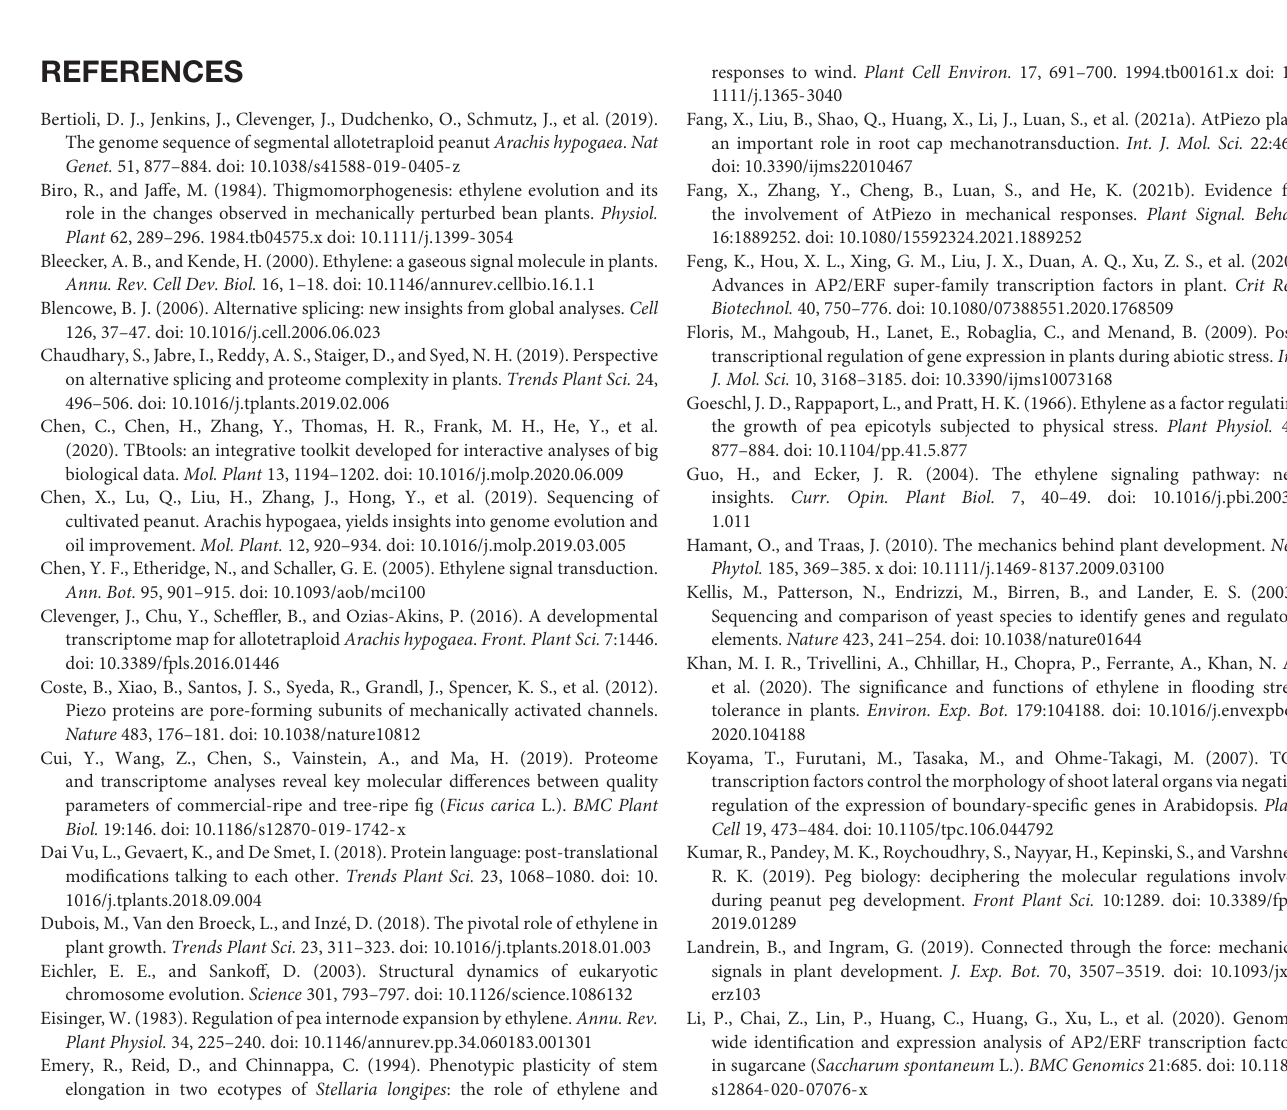
Supplementary Table 5 | The FPKM values of AhAP2/ERFs during developmental stage. Supplementary Table 6 | Promoter elements